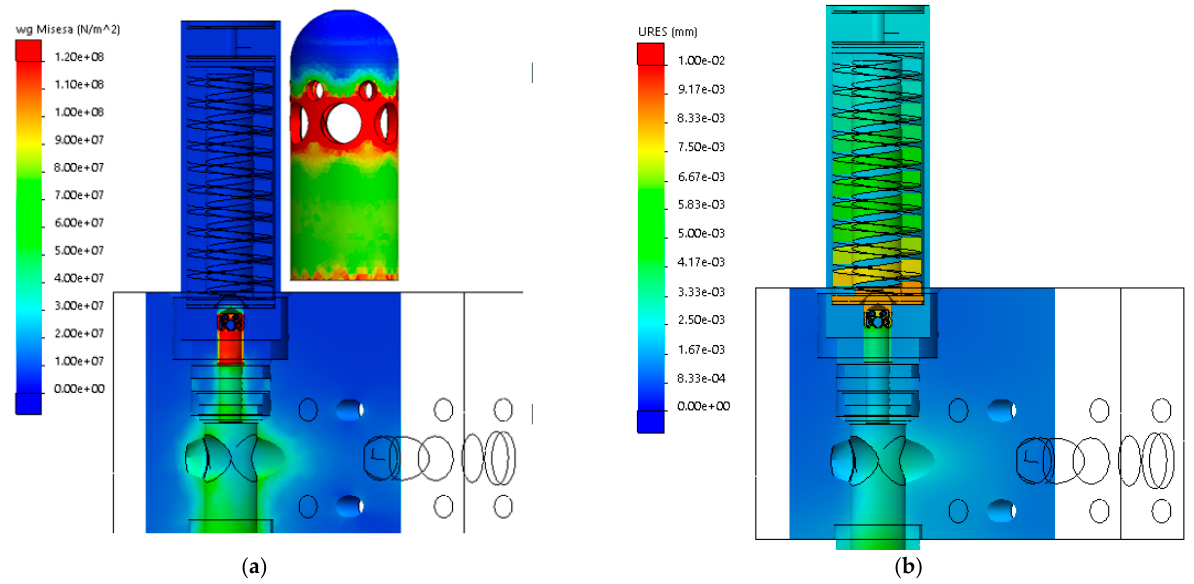
Figure 22. The variation map of von Misses stress ( σ ) ( a ) and displacement ( d ) ( b ) for a 0.0033 m 3 ·s -1 volume flow rate (200 L·min -1 ).